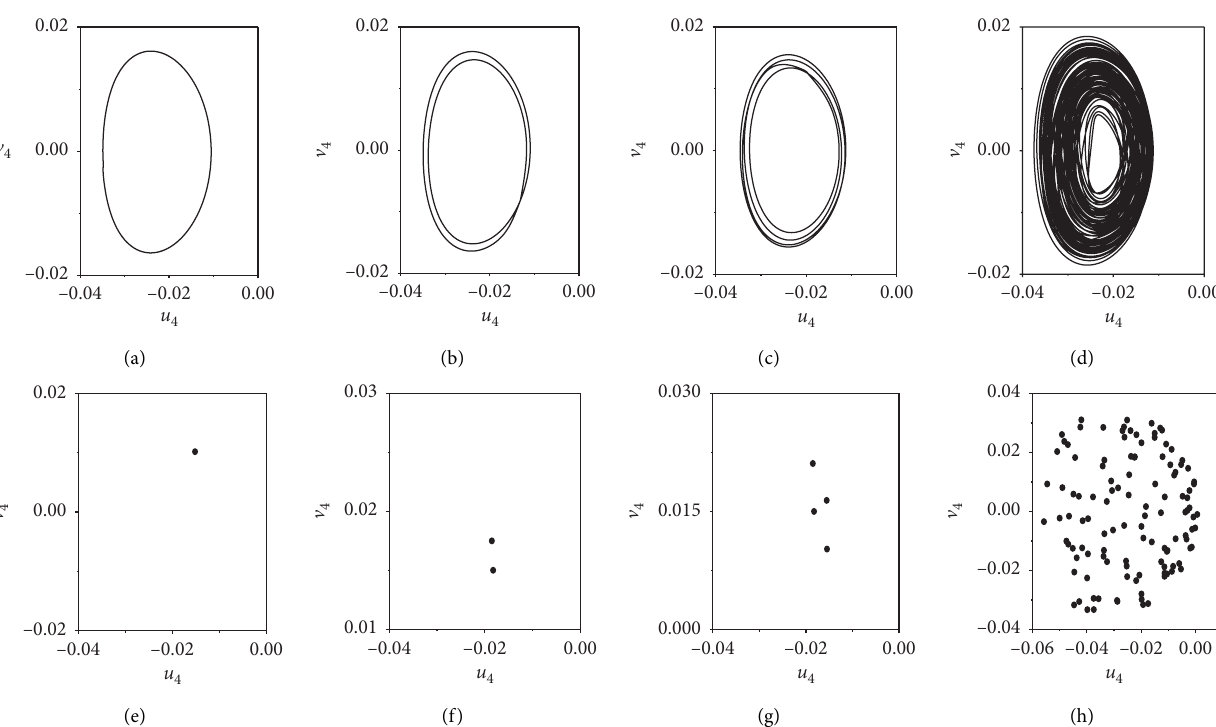
− v � 0 . 05587 (1P); (b, f) σ phase. (a, e) σ 4 4 2